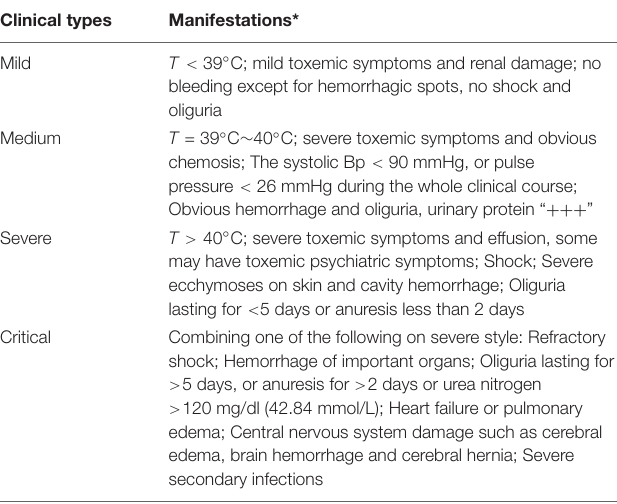
TABLE 1 | Standard for the classification of HFRS